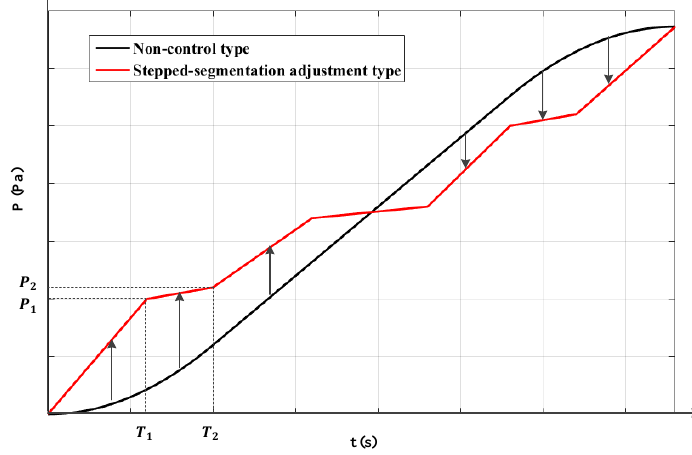
Figure 3. Segmented adjustment curve.